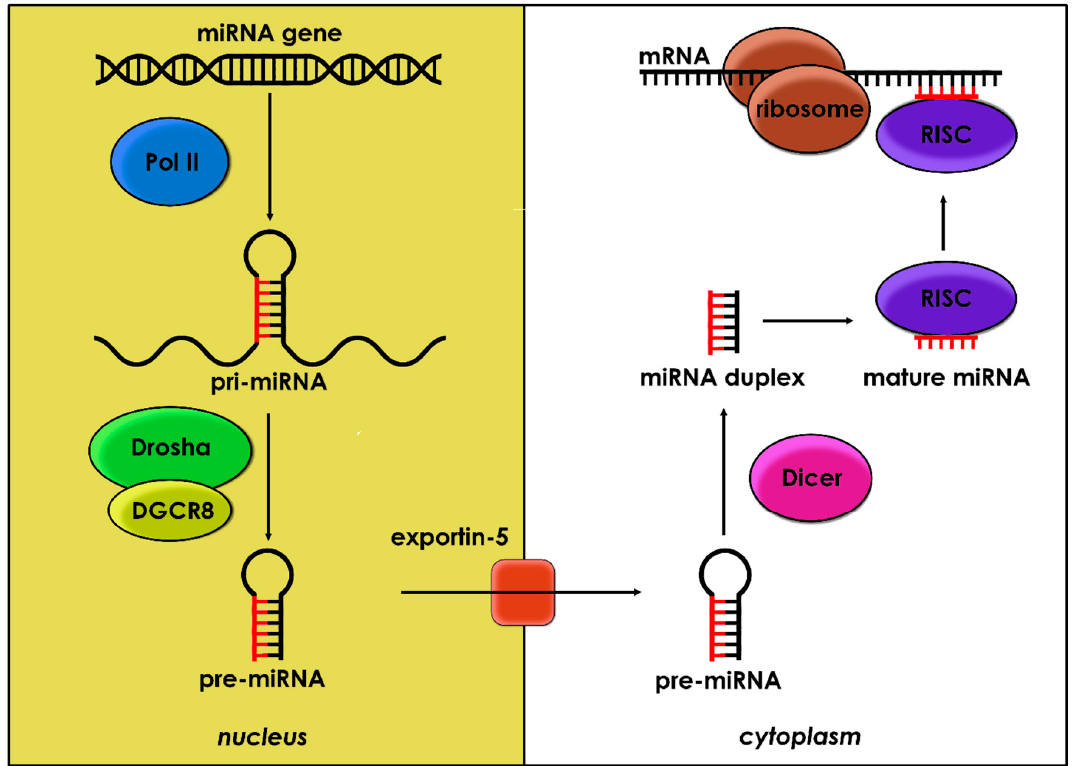
Figure 1. miRNA biogenesis. The red strand represents the guide strand and the black strand represents the passenger strand. Abbreviations: Pol II = polymerase II, pri-miRNA = primary miRNA, pre-miRNA = precursor miRNA, DGCR8 = DiGeorge syndrome critical region in gene 8, RISC = RNA-induced silencing complex.